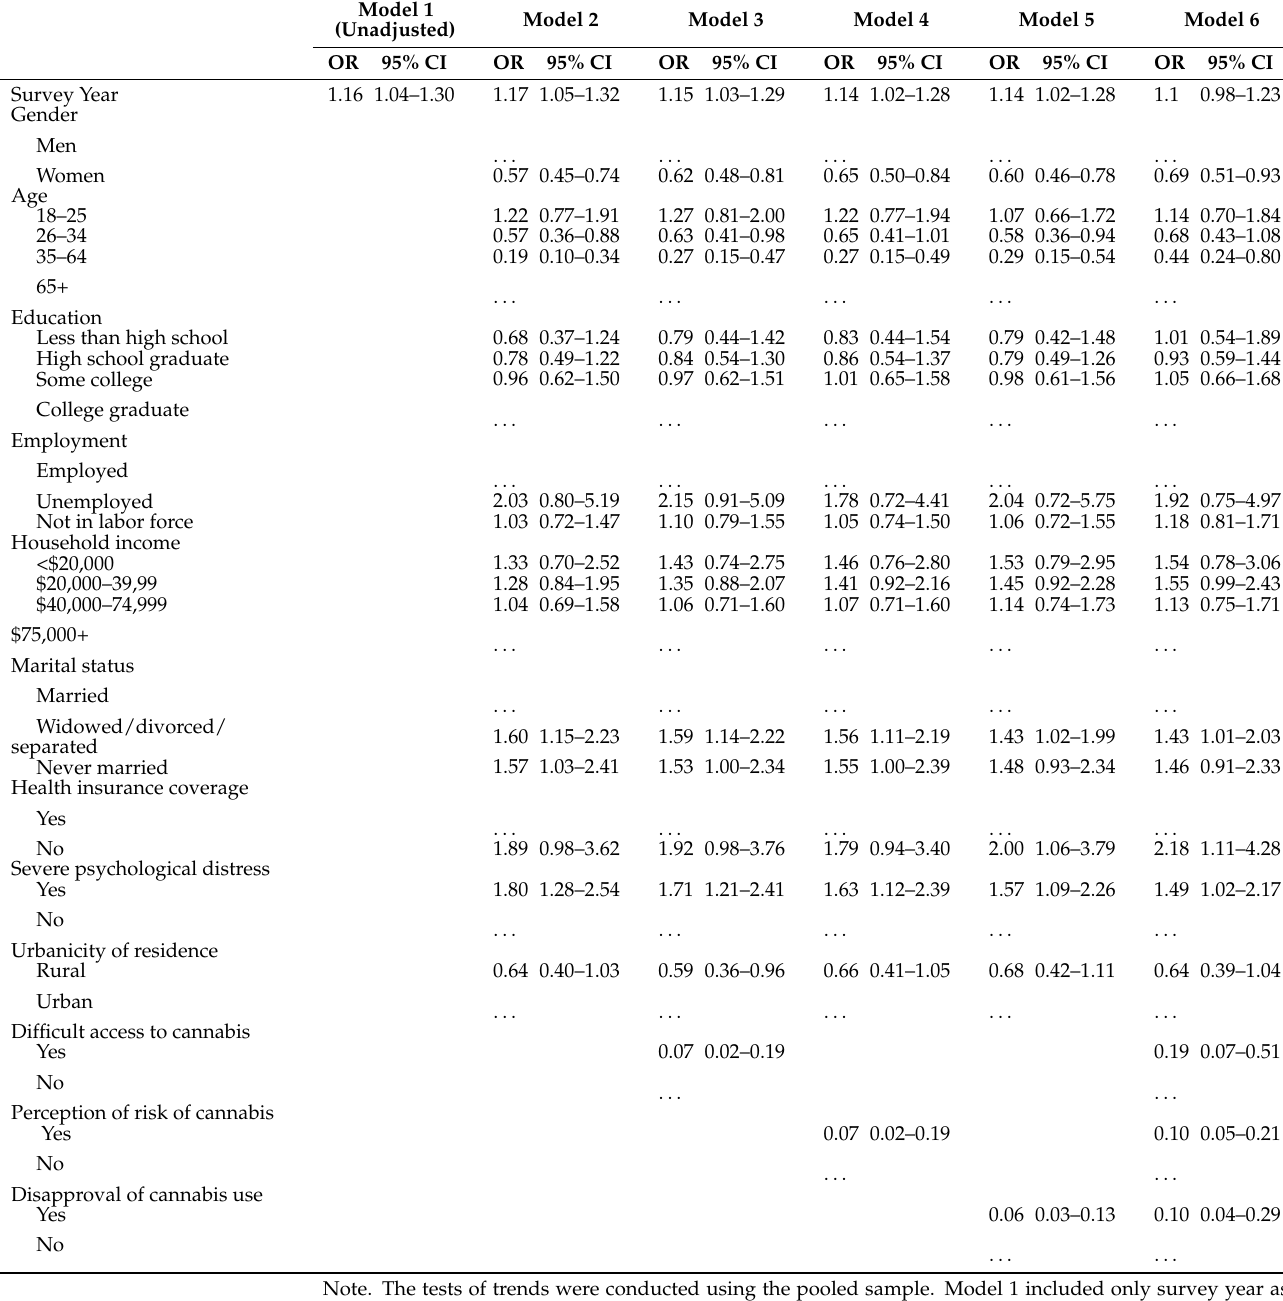
Table A4. Test of trends in cannabis use among non-Hispanic Whites with heart disease: pooled sample of NSDUH